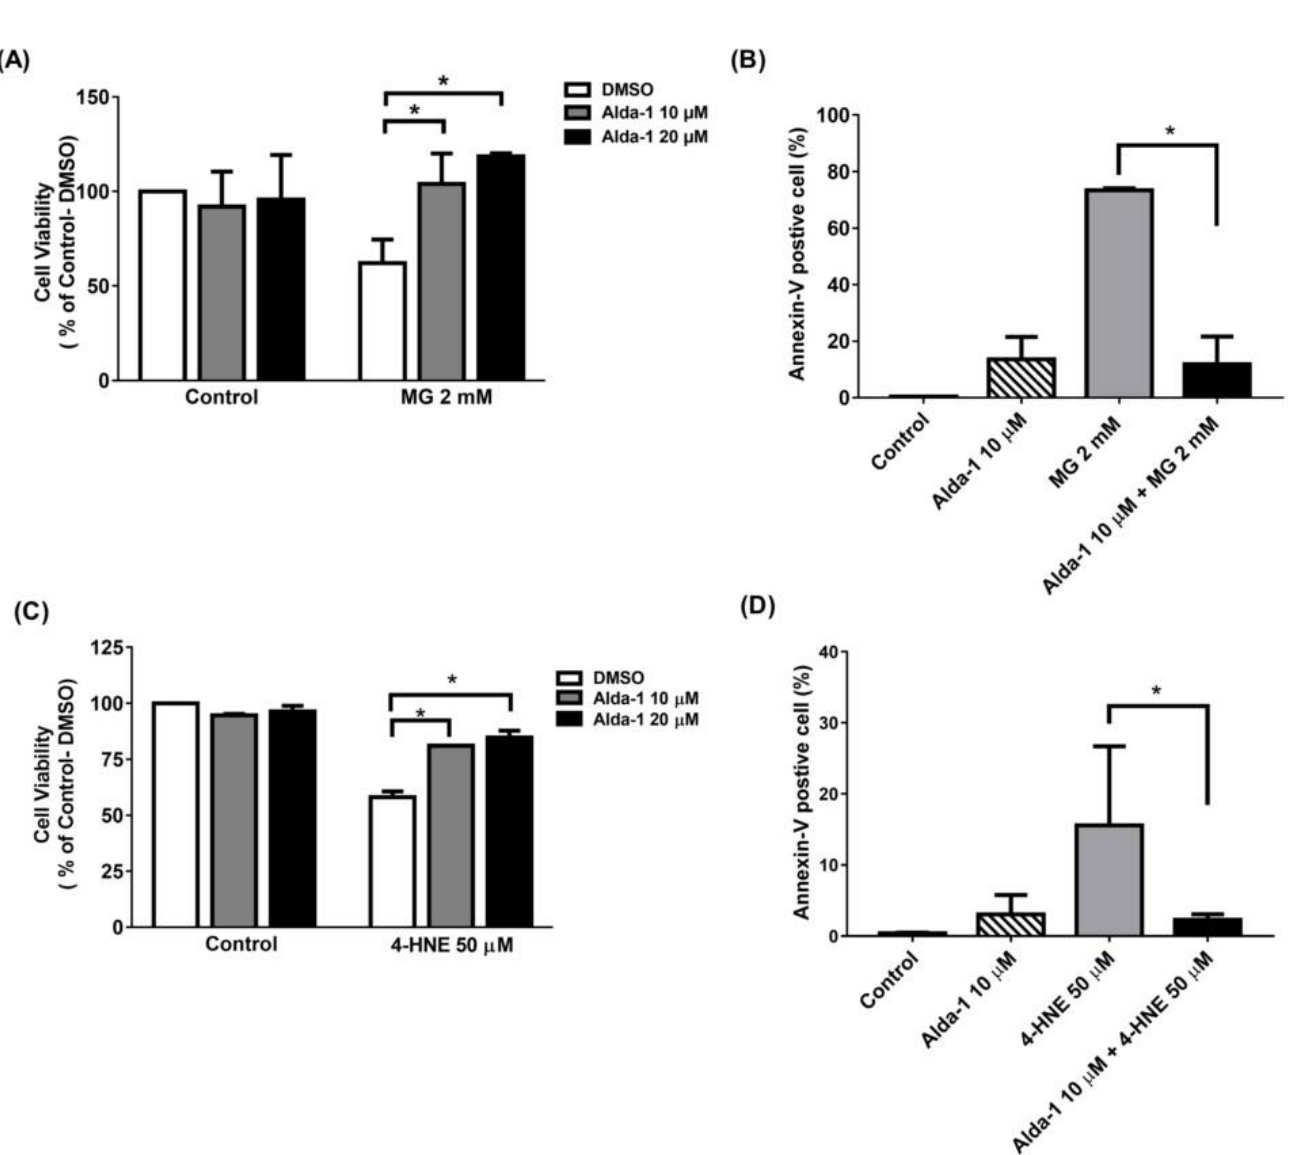
Figure 3. Alda-1 rescues the cell death induced by glucotoxicity and lipotoxicity via anti-apoptotic effect. ( A ) Cell viability in the control and Alda-1-treated MIN6 cells in the absence and presence of 2 mM methylglyoxal (MG). ( B ) The percentages of Annexin-V-positive and AAD-7-negative MIN6 cells treated with or without Alda-1 in the absence and presence of 2 mM methylglyoxal (MG) for 24 h. ( C ) Cell viability in control and Alda-1-treated MIN6 cells in the absence and presence of 50 μM 4-Hydroxynonenal (4-HNE). ( D ) The percentages of the Annexin-V-positive and AAD-7-negative MIN6 cells treated with or without Alda-1 in the absence and presence of 50 μM 4-HNE for 24 h. Data are presented as mean ± SEM of three independent experiments (n = 3 per group). * p < 0.05.